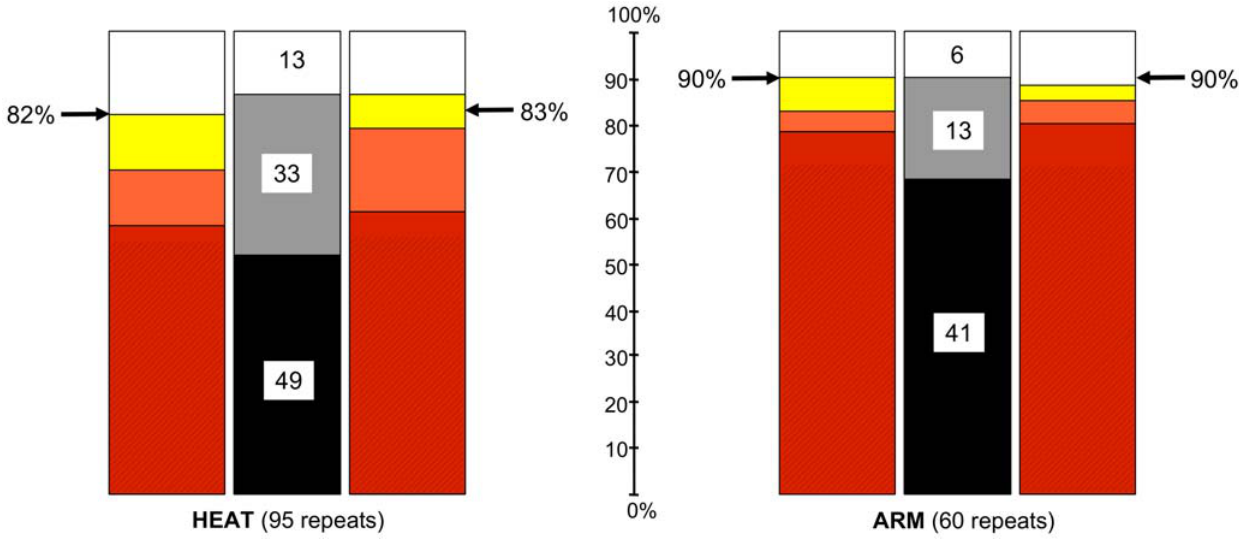
Figure 8. Repeat detection in dependence of reference and query alignments. The outer bars summarise the results of COACH runs with the three reference alignments, and different query alignments as described in the text (left-hand bars: query alignments as used in the calibration; right-hand bars, query alignments taken from the Established Repeat data, including N-and C-terminal repeats). Red: repeats detected with all three reference alignments (hatched area: repeats also detected by HHpred); orange: detected with two of the reference alignments; yellow: detected with one of the reference alignments; white: not detected with any of the reference alignments. Arrows mark the respective detection rates achieved with the protocol, which combines the results from the HHpred and the COACH (Established Repeats) runs. The inner bars summarise the results from all runs for each repeat type, including HHpred. Black: repeats detected in all eight runs; grey: repeats detected in one to seven runs; white: repeats not detected in any of the runs. The numbers given are how many repeats fall into each